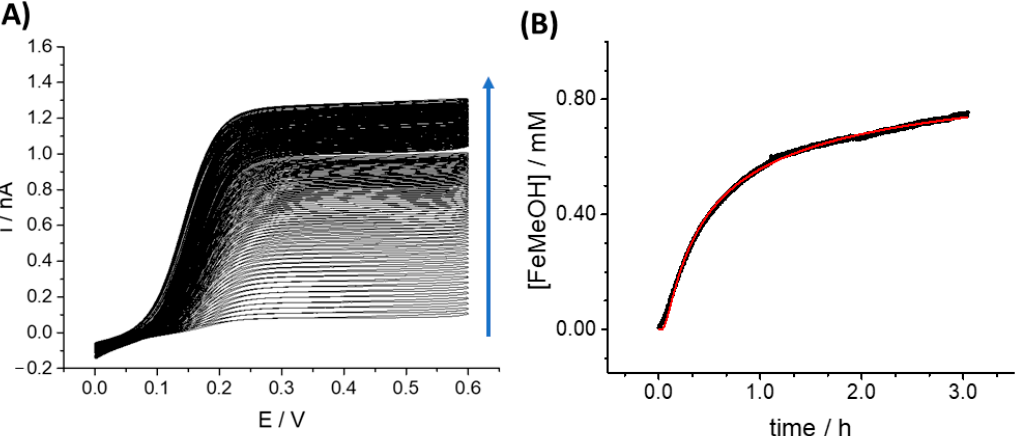
Figure 9. ( A ) Cyclic Voltammetries of FeMeOH diffusion in 3D bioprinted tissue. Measurement of FeMeOH diffusion in the 3D alginate sample followed by cyclic voltammetry over time. Oxidation current increased as FeMeOH concentration increased over time (the direction of the blue arrow indicates increasing time). ( B ) Diffusion coefficient curve of FeMeOH (black curve) in the alginate 3D sample obtained from repeated cyclic voltammetries; the best fitting (red curve) using the eq. 1 was calculated using OriginPro 9.1 software. Values of free parameters for the best fit are C 0 = (1.705 ± 0.003) mM and D = (2.57 ± 0.02) cm 2 s − 1 . The distance of the microelectrode from the nearest construct/solution boundary, x , was kept as x = 0.8 mm as a non-adjustable parameter during best fit. This value was measured from the SECM approach curve to the bottom of the Petri dish.